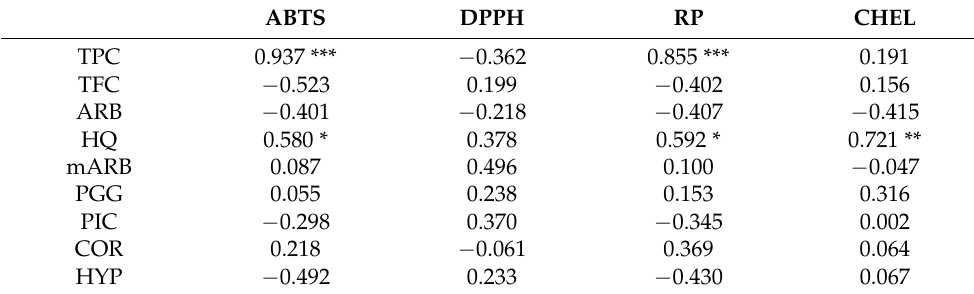
Table 4. Relationships (Pearson correlation coefficients) between the secondary metabolites of bearberry WE and antioxidant parameters. TPC—total phenolic concentration, TFC—total